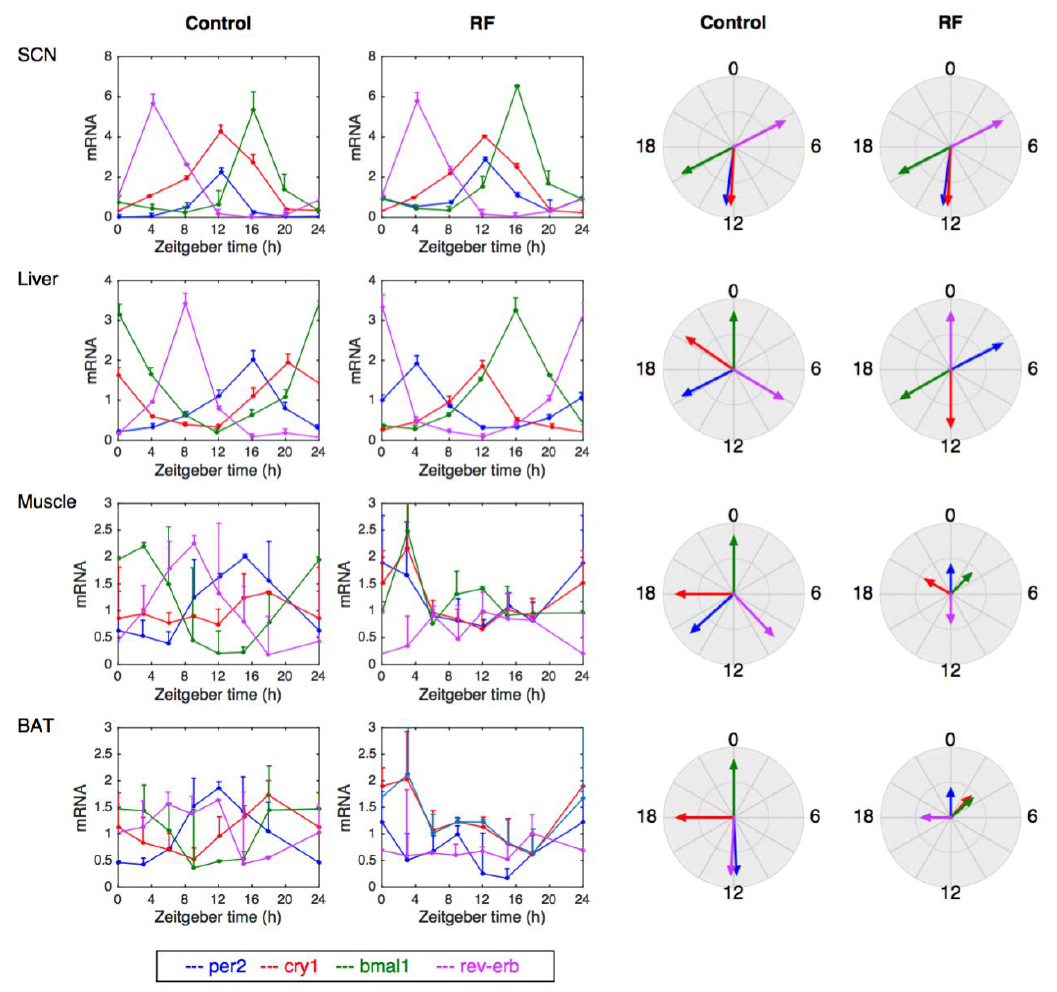
Figure 2. Experimentally measured clock gene expression in different organs in control (ad libitum) and daytime-restricted feeding (RT) conditions in rodents. Data for the suprachiasmatic nucleus (SCN) and liver are from [81]. Data for muscle and brown adipocytes (BATs) are from [84]. Note that for muscle and BATs, the data at t = 24 h are replicated from data at t = 0. The circle plots on the right show the phase of the peak of gene expression. The small size of the arrows for muscle and BATs under RT reflects the fact that the rhythmicity in these conditions is strongly altered. This figure highlights the organ-specific phase relationships between the expression profile of core clock genes and the gene-specific alteration of the expression profile under RT.